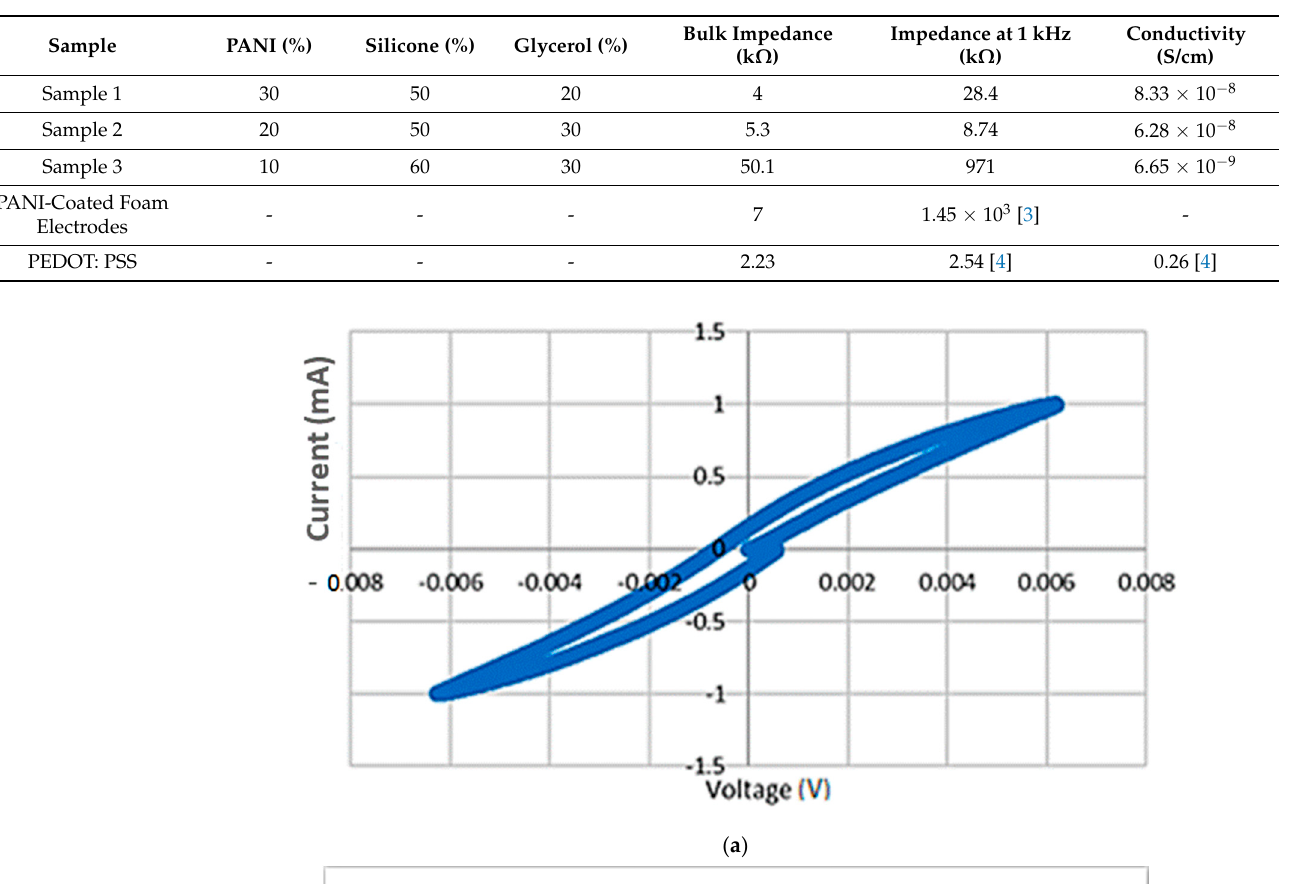
Table 2. Comparison between different prepared electrode mass compositions.